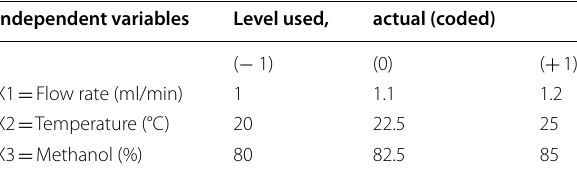
Table 2 Screening variables and their levels (in coded and actual) used for 3 2 factorial design Independent variables